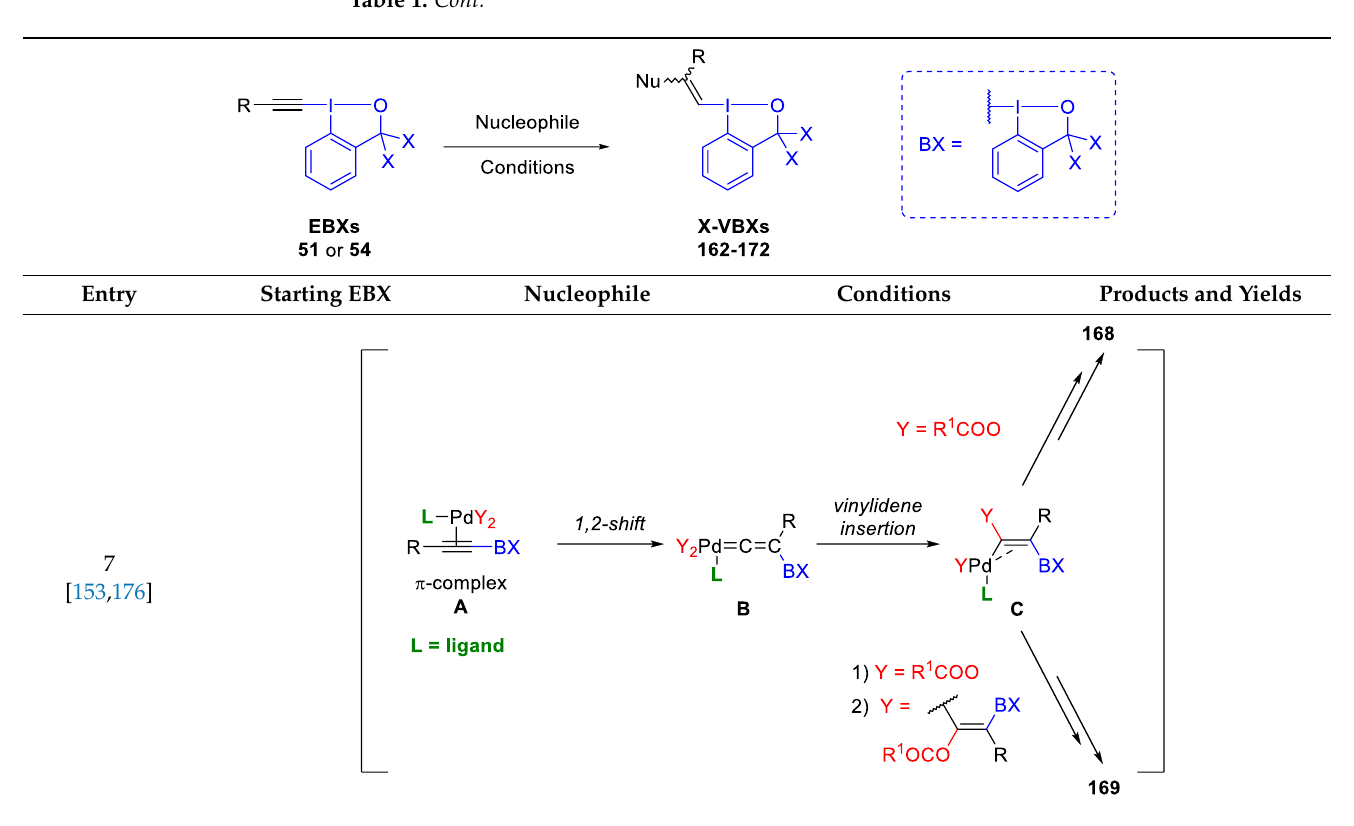
Table 1. Cont. Table 1. Preparation of X-VBX [74,140,143,153,167 –